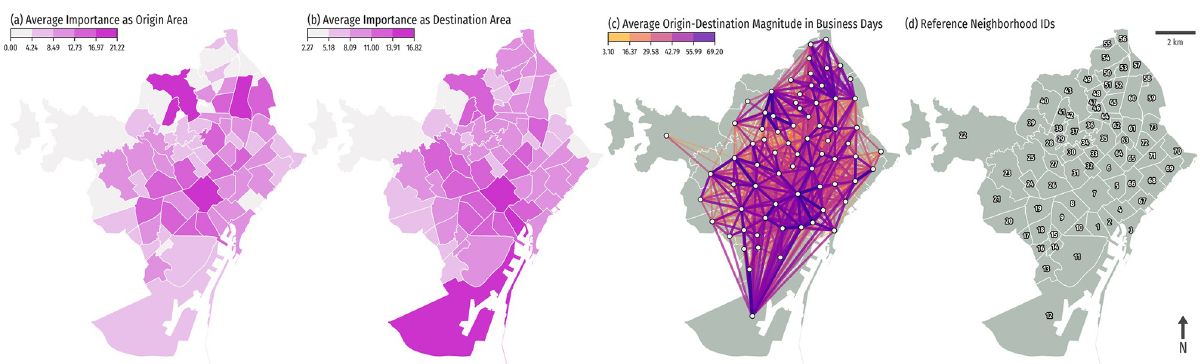
Fig 2. Origin-destination flows between neighborhoods in Barcelona. a) Map of average importance as origin area (neighborhoods). b) Map of average importance as destination area (neighborhoods) for local people in Barcelona. c) Node-link diagram of the flow network, with links color coded by the flow importance (log-transformed, monthly average in business days). d) The official reference neighborhood identifiers of the city. Administrative boundaries are sourced from CartoBCN under a CC BY 4.0 license, with permission from Ajuntament de Barcelona , original copyright